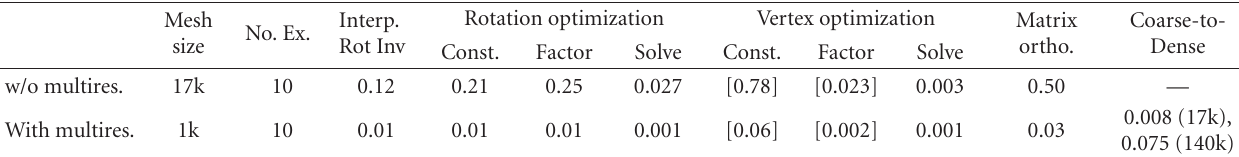
Coarse-to- ortho.